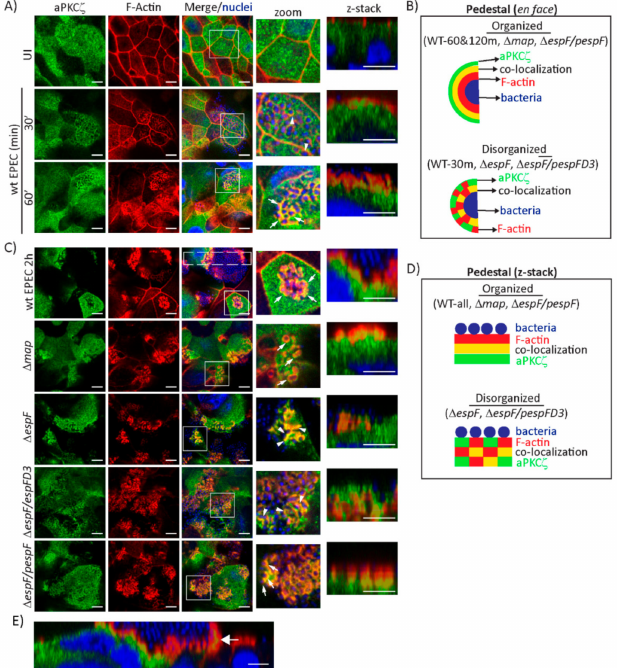
Figure 2. EspF and its SNX9-binding domain are crucial for the structural organization of F-actin and aPKC ζ within EPEC pedestals. SKCO-15 monolayers were infected with wt EPEC, ∆ map, ∆ espF , ∆ espF / pespF D3, or ∆ espF / pespF to assess F-actin and aPKC ζ co-localization. ( A ) F-actin and aPKC ζ are recruited to and co-localize around attached bacteria at 30 and 60 min post-infection with wt EPEC. Zoom and z-stack images at 60 min display EPEC pedestals with attached bacteria surrounded by F-actin, an interface of co-localized F-actin and aPKC ζ , then aPKC ζ alone. ( B ) Schematic of F-actin (red), aPKC ζ (green), and co-localizing interface (yellow) organization around bacteria after infection with wt EPEC and mutant strains. ( C ) aPKC ζ recruitment to pedestals is maintained at 2 h post-infection with wt EPEC. Zoom and z-stacks reveal the robust organization of F-actin and aPKC ζ co-localization. Deletion of map ( ∆ map ) does not alter aPKC ζ recruitment to pedestals. Infection with ∆ espF and ∆ espF / pespF D3 causes disorganization of co-localized F-actin and aPKC ζ within pedestals. Complementation of espF ( ∆ espF / pespF ) restores the organized phenotype. Squares correspond to zoom and z-stack areas in all except wt EPEC, in which a large rectangle corresponds to z-stack image. Arrows and arrowheads indicate organized and disorganized pedestals, respectively. ( D ) Schematic representation of pedestals showing the organized and disorganized localization of F-actin (red), aPKC ζ (green), and co-localizing interface (yellow) after infection with wt EPEC and mutant strains. ( E ) aPKC ζ also co-localizes with F-actin in filopodia (arrow) 2 h post-infection with wt EPEC. Scale bars: 10 µ m (en face); 5 µ m